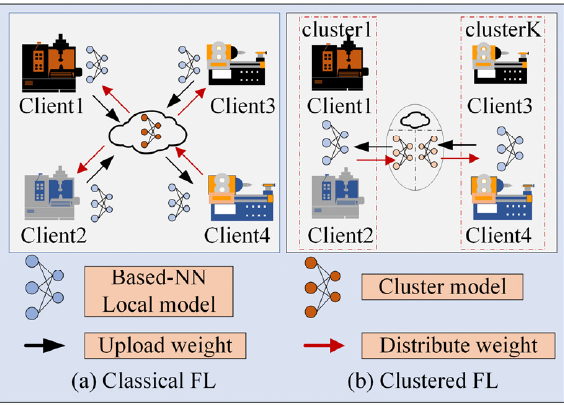
Figure 4. Schematic diagram of the comparison between FL and CFL. During the clustering procedure, the features are extracted from self-attention mecha- nism, which further extracted the statistical average information along each channel as the input of k -means clustering. It not only reduces the additional calculation amount, but also avoids possible data privacy leakage. Then, the unsupervised clustering is further imple- mented to determine the similarity of clients, which can not only effectively utilize data resources with high similarity, but also reduce the impact of data distribution discrepancy on model performance. Specifically, after the server receives the statistical average representation vectors and model weights are uploaded by the clients, an unsupervised clustering algorithm is performed first to divide the clients into different cluster groups with similar data distribution. In the proposed scenario, since there are not many categories and the data dimension is not high, a k -means clustering algorithm with the specified number of clusters is directly used. The objective optimization function is as follows: